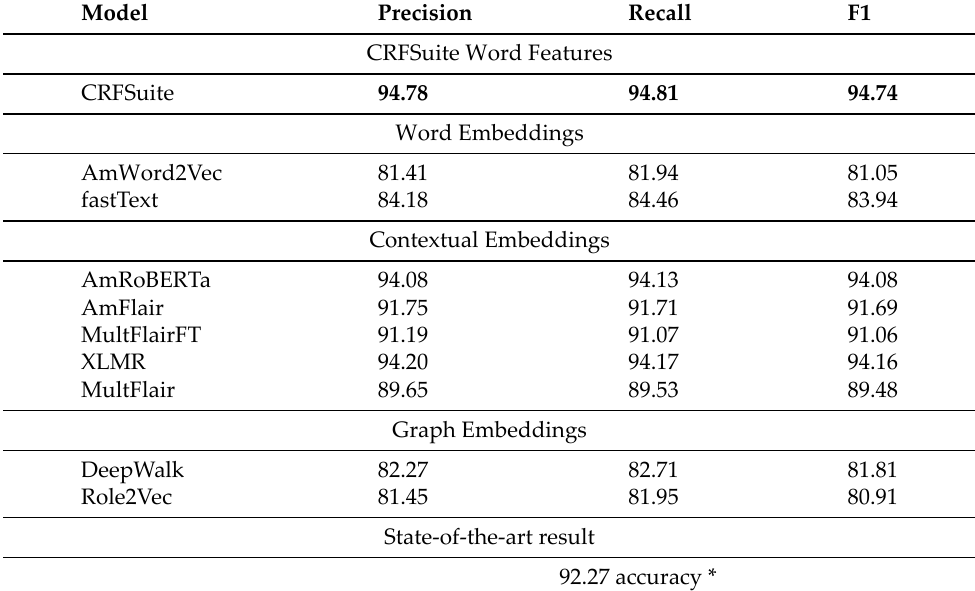
Table 6. Experimental results for POS tagging (macro‑averages). * indicated the stat‑of‑the‑art result of the ELRCQB dataset but the results are not comparable as: (1) The reported result shows only the accuracy, and (2) they are not benchmark